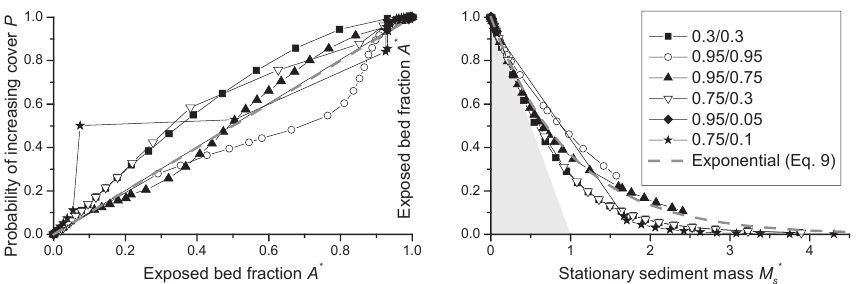
Figure 4. Probability functions P and cover function derived from data obtained from the model of Hodge and Hoey (2012). The grey dashed line shows the exponential benchmark behaviour. Grey shading depicts the area where the cover function cannot run due to conservation of mass. The legend gives values of the probabilities of entrainment p i and p c used for the runs (see text).